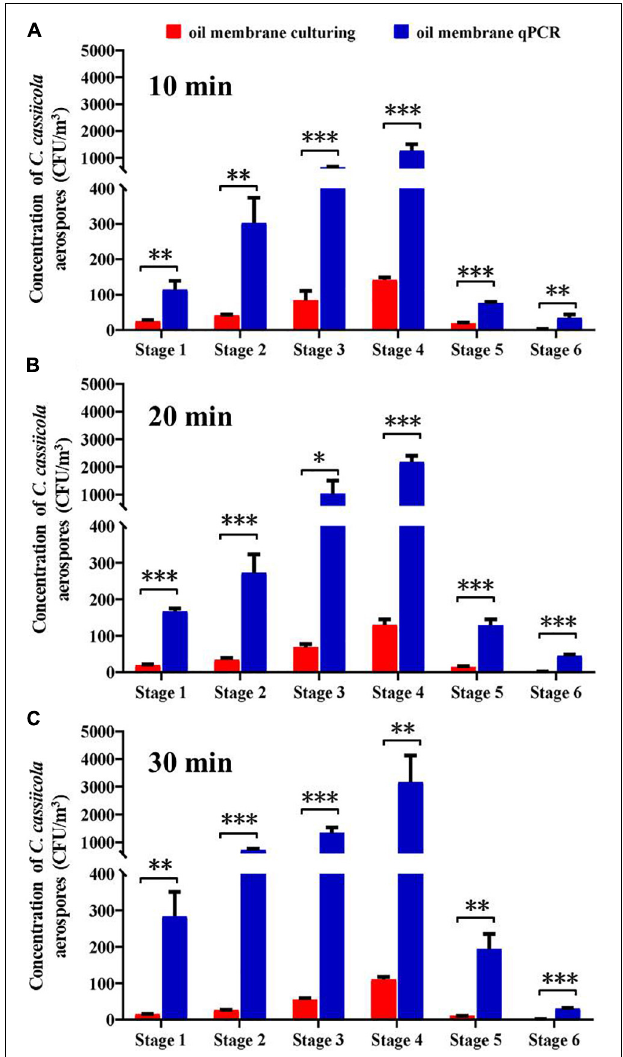
FIGURE 3 | Size specific biological detection efficiencies of Andersen six-stage sampler together with oil membrane in sampling aerospores of aerosolized Corynespora cassiicola by culturing and qPCR methods under (A) 10 min, (B) 20 min, and (C) 30 min in the exposure chamber. Mineral oil (600 µ L) was evenly spread onto a 90 mm diameter sterilized aluminum membrane on a Petri dish. Error bars represent the standard deviation from three independent repeats, and they are in both directions. The effects of culturing and qPCR methods on the concentrations of C. cassiicola aerospores were analyzed using one-way ANOVA tests. ∗ indicates P < 0.05, ∗∗ indicates P < 0.01, and ∗∗∗ indicates P <